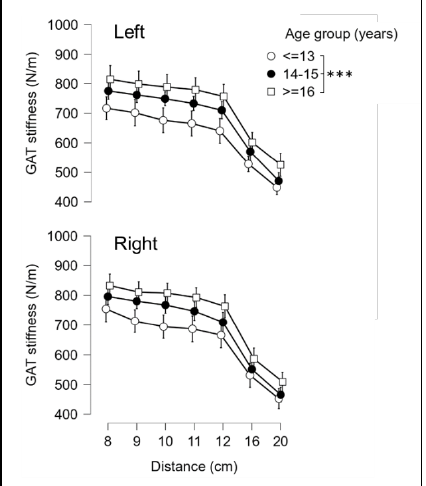
Figure 3. Gastrocnemius – Achilles tendon unit (GAT) stiffness at 8, 9, 10, 11, 12, 16, and 20 cm from the plantar aspect of the heel for the three age groups in left ( top ) and right ( bottom ) limbs. Error bars represent a confidence interval of 95%. *** = significantly different between groups ( p < 0.001).